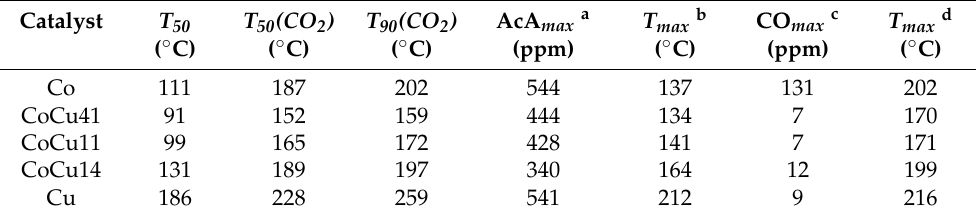
Table 6. Catalytic properties of the examined Co-Cu oxide catalysts (oxidation of 750 ppm of ethanol in air at GHSV of 20 l g cat − 1 h − 1 ).